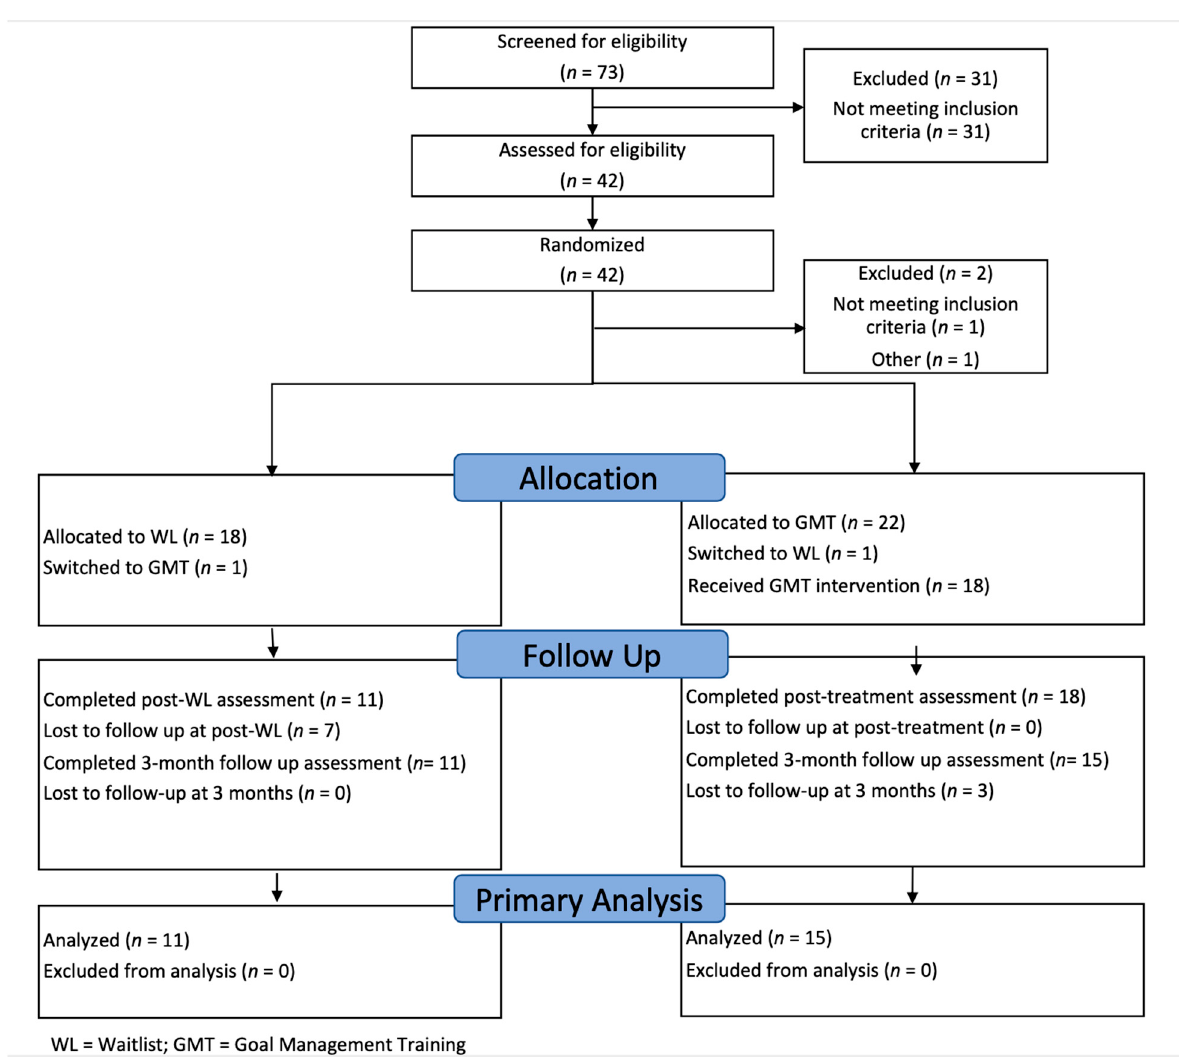
Figure 1. CONSORT diagram depicting recruitment, drop-out, and follow-up of study participants. Table 1. Demographic and clinical characteristics of eligible